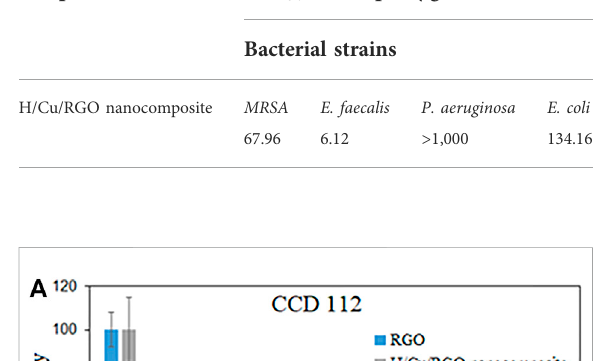
TABLE 1 MIC 50 values of H/Cu/RGO nanocomposite against four bacteria strains. Sample